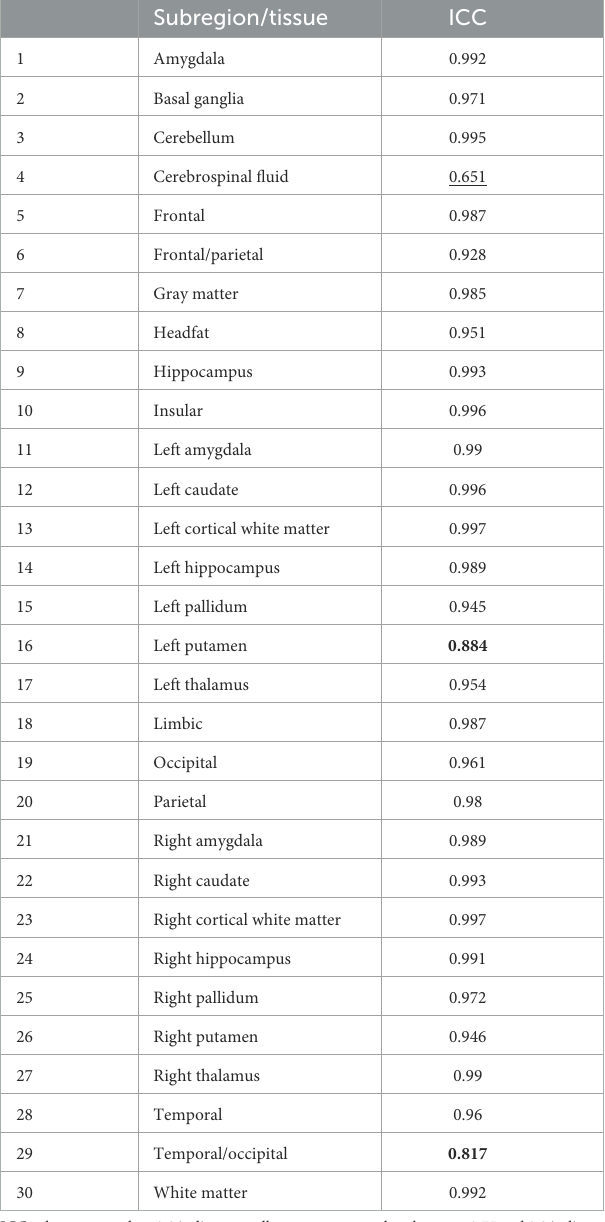
TABLE 3 Individual inter-class agreement coefficient (ICC) values for each of the 27 subregions and 3